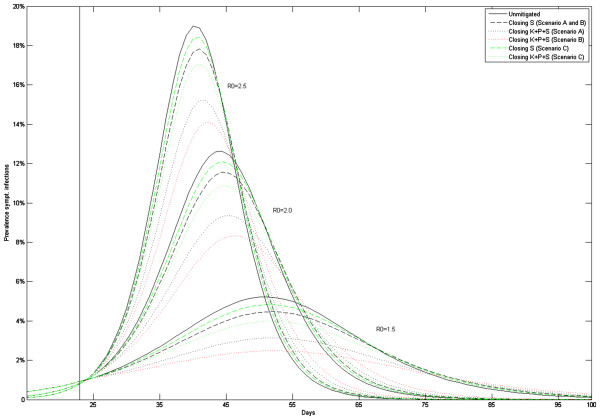
Epidemic curves showing the prevalence of symptomatic infections for unmitigated pandemic versus implementing a 12-week school closure with R0=1.5, 2.0 and 2.5.